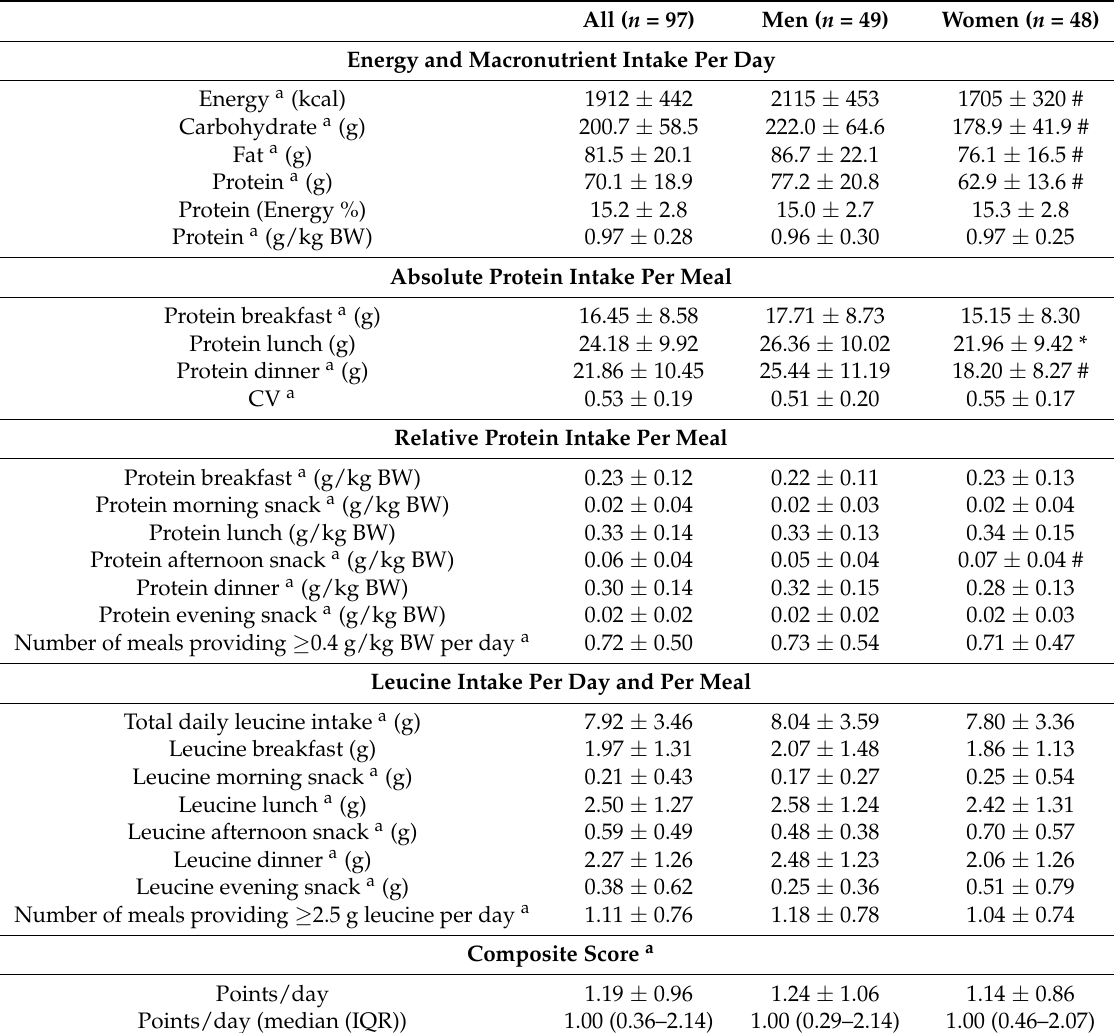
Table 3. Daily mean dietary intake data obtained from 7-day food records of the total healthy community-dwelling sample of older adults and subgroups of male and female participants (mean ± standard